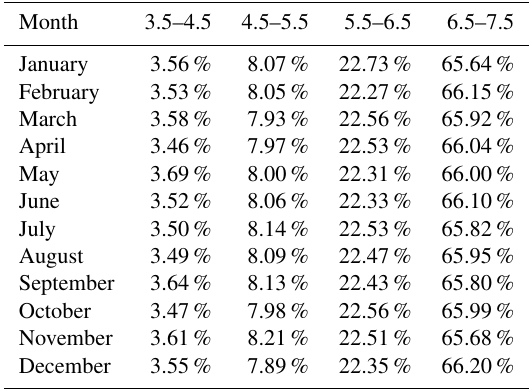
Table 9. Star magnitude statistics of